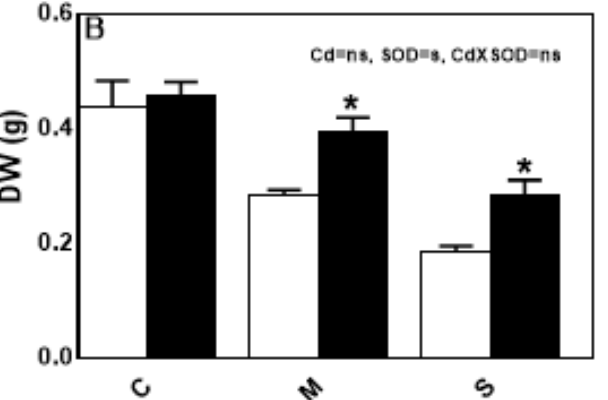
Figure 6. Effect of Cd-stress levels (C; control, M; mild and S; severe) on ( A ) fresh weight (FW) and ( B ) dry weight (DW) of the FeSOD overexpressing maize transgenic line (TG) and its wild type (WT). Values expressed as means ± SE ( n = 5). Bars with (*) indicate significant difference. Two-way ANOVA was applied to study the effect of the two factors, Cd-stress (Cd) and SOD overexpression (SOD), as well as their interaction (Cd × SOD).